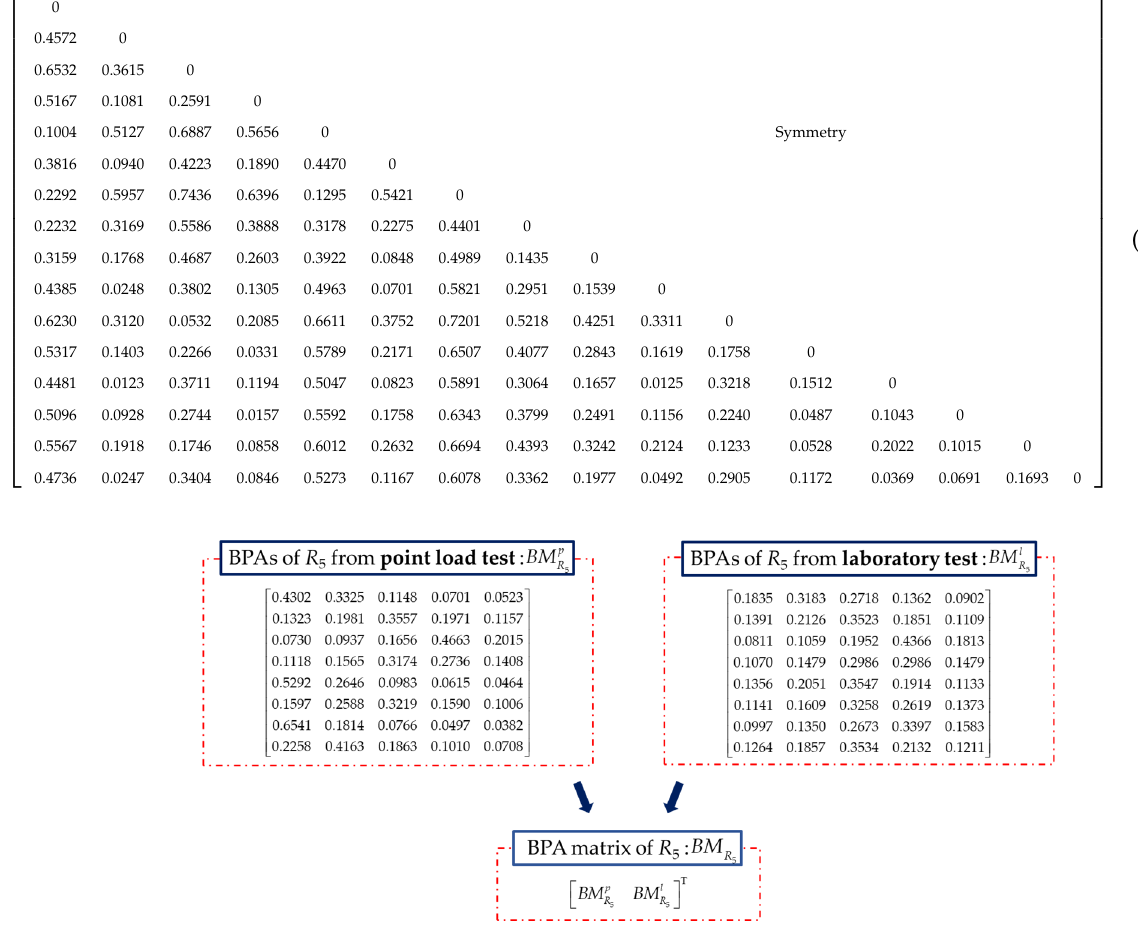
BM constructed with BPAs of R 5 . Figure 13. Figure 13. BM R constructed with BPAs of R 5 . 5 R 5 The initial data fusion in each rock mass index is generated by the proposed method before the further fusion. The result of initial fusion of each index is shown in total in Figure 14. Some rock mass rating indices have different rating levels with the maximum probability ( R 1 , R 3 , and R 5 ), and others have almost the same probability in two rating levels ( R 2 and R 4 ). It is difficult to decide the exact rating level of the quality of the rock mass in this section, which means that further fusion is needed for the quality evaluation of rock